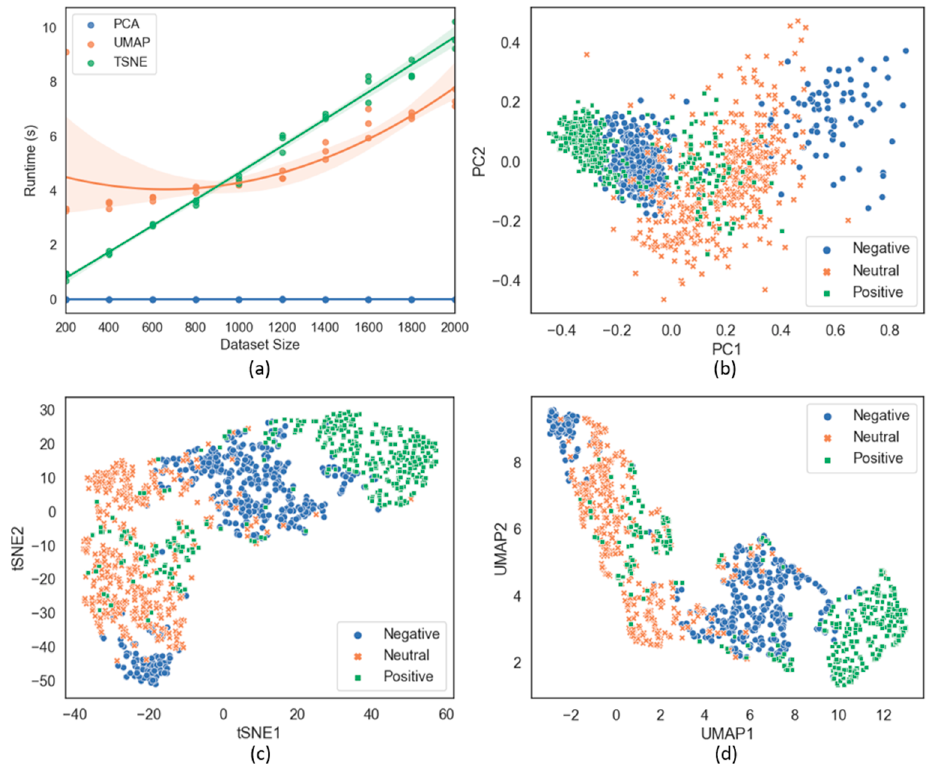
Figure 13. ( a ) Runtime of three dimensionality reduction techniques (PCA, t-SNE, and UMAP). ( b ) Data visualization after using PCA with n_components = 2, svd_solver = auto. ( c ) Data visualization after using t-SNE with n_components = 2, metric = ‘Euclidean’. ( d ) Data visualization after using UMAP with n_components = 2, metric = ‘Euclidean’. Data were obtained by using SAE on Subject 2.